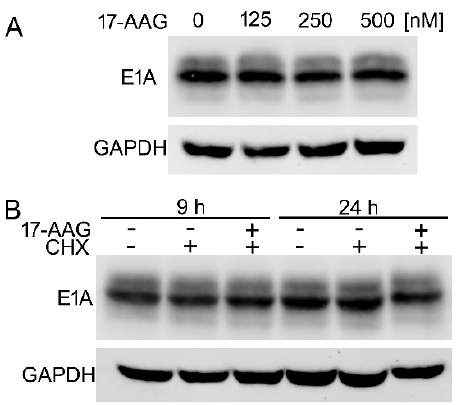
Figure 7. Hsp90 inhibition does not increase degradation of the mature E1A. ( A ) HEK293 cells were cultured for 24 h with the indicated concentrations of 17-AAG. ( B ) HEK293 cells were incubated with 500 nM 17-AAG, or with 500 nM 17-AAG and 100 μ g/mL cycloheximide (CHX) for 9 and 24 h. Control cells were cultured without the inhibitors. E1A and GAPDH in the extracts were detected by western blot. Representative western blot, one of two performed is shown.